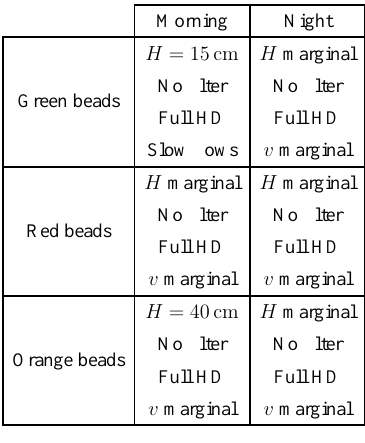
Table 3. Summary of the optimal testing conditions for the sensing station under varying light